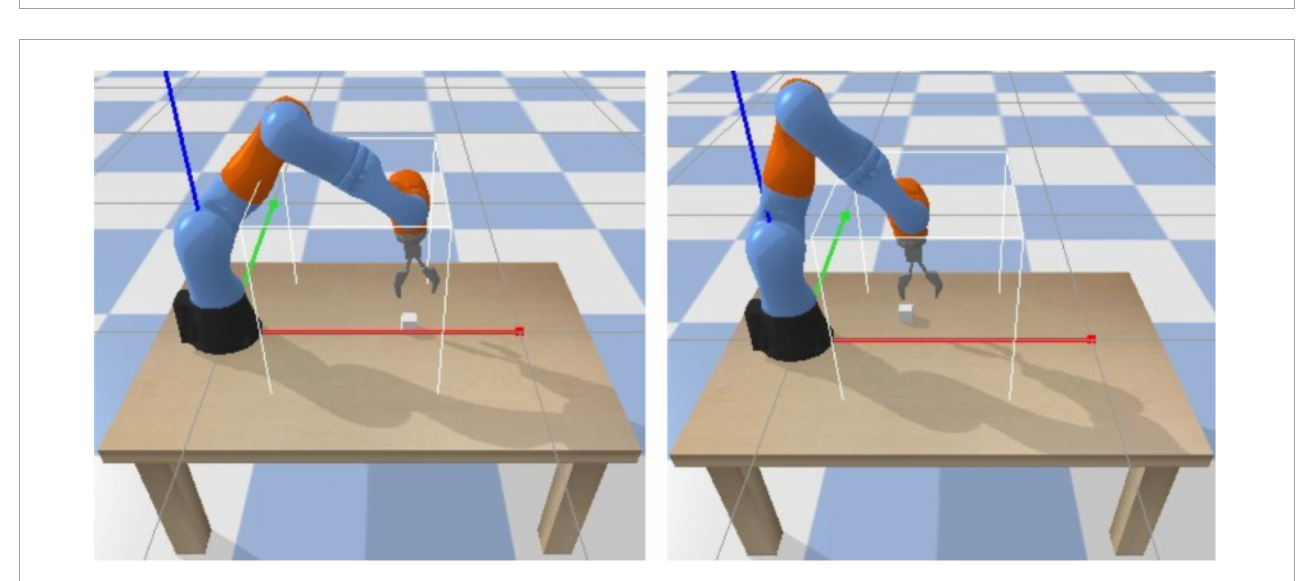
FIGURE6 3D simulation environment for the robotic arm.